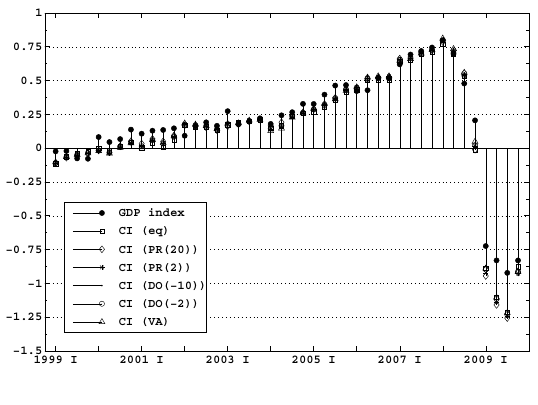
Figure 5. CI and GDP changes compared to corresponding period of the previous